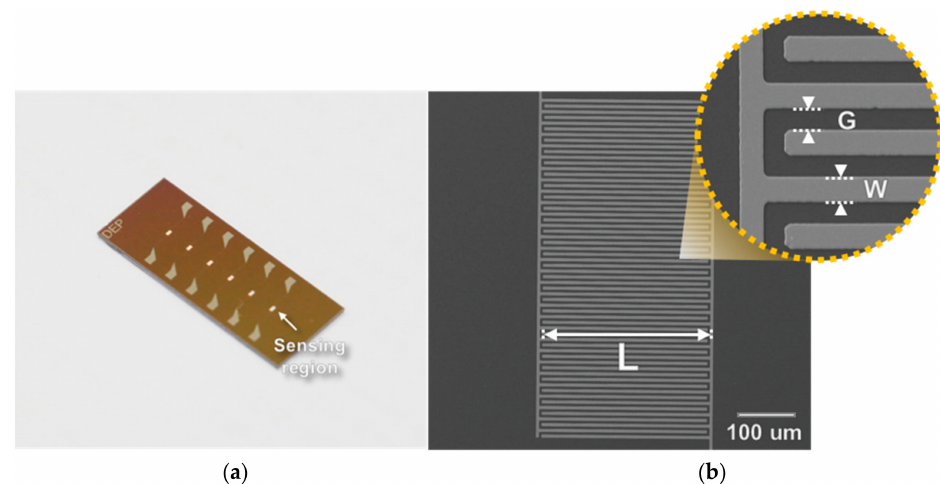
Figure 3. ( a ) Interdigitated microelectrode (IME) sensor for the detection of A β . ( b ) × 200 Scanning Electron Microscopy (SEM) image of the sensing region.